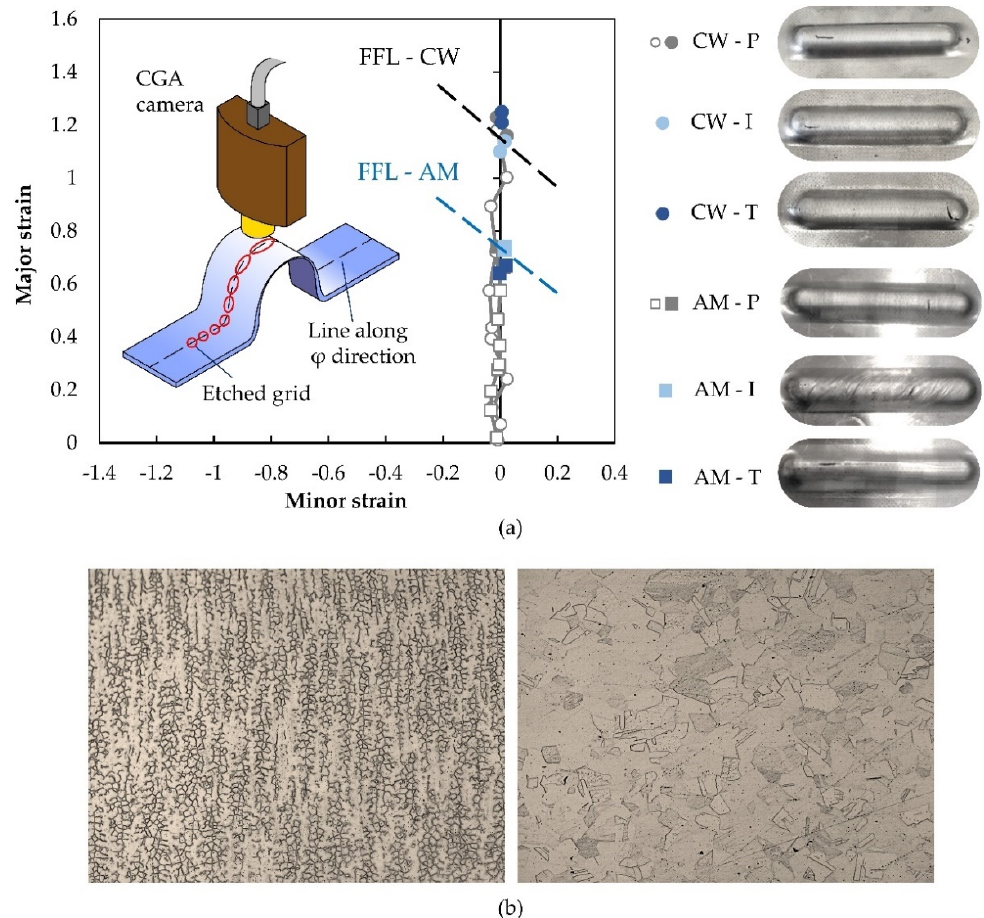
Figure 6. ( a ) Principal strain space showing the experimental strains that were measured by circle grid analysis in both additively deposited and wrought commercial sheets with photographs, showing details of the test specimens; ( b ) microstructures of metallographic samples taken from the (left) additively deposited and (right) wrought commercial AISI 316L stainless-steel sheets.